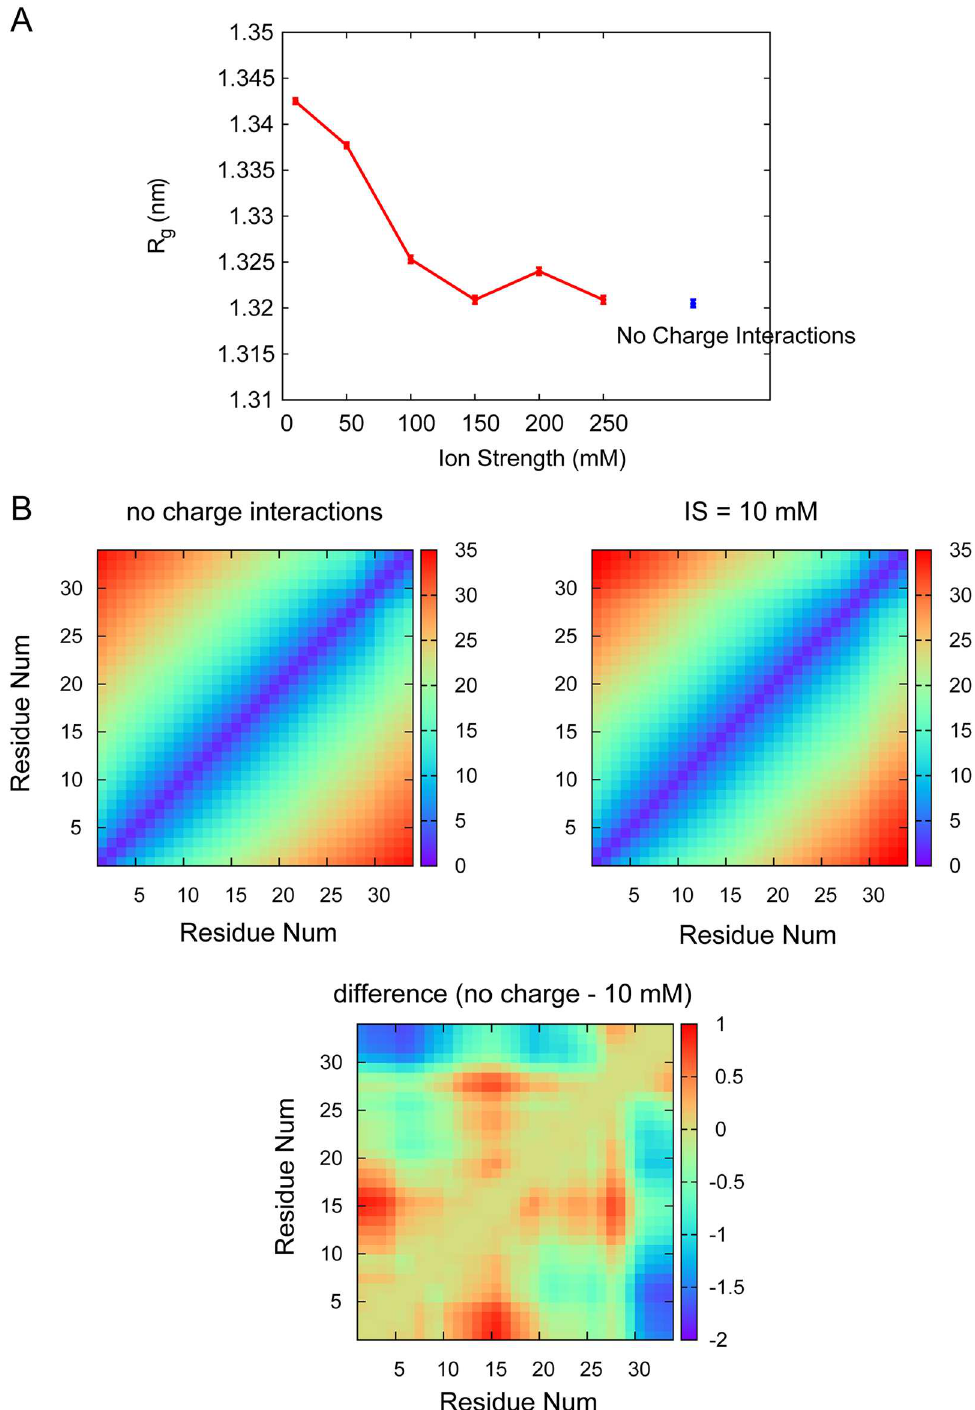
Fig 2. Radius of gyration and distance map results. (A) Average radius of gyration ( R g ) with standard error of unboundPUMA dependsupon ionic strength. Simulationswere performed using models of variousionic strengths from 10 mM to 250 mM (red dots). Blue dot indicates R g obtainedwhen charge-charge interactions are not includedin the model. (B) Distance map of C α - C α atoms of unboundPUMA with no charge-charge interactions(left) and high charge interactions of IS = 10 mM (right). The value of distanceincreasesfrom 0 Å (blue) to 35 Å (red). The difference of residue-residuedistancebetweenthe PUMA without charge interaction and PUMA in 10 mM salt solutionis shown in